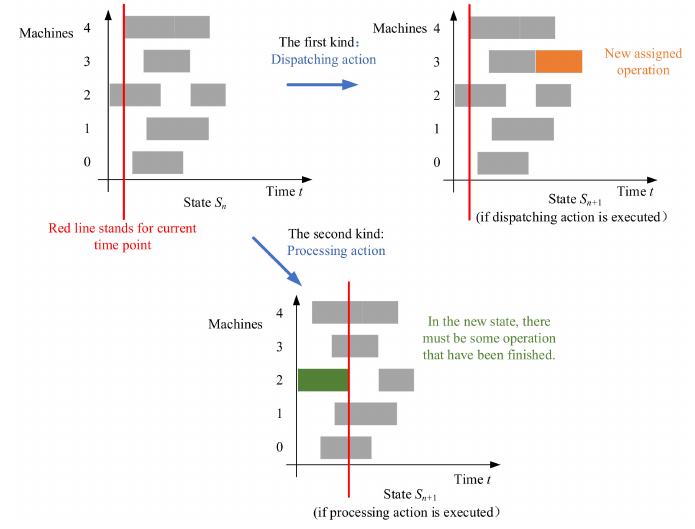
Figure 6. The state transition of the